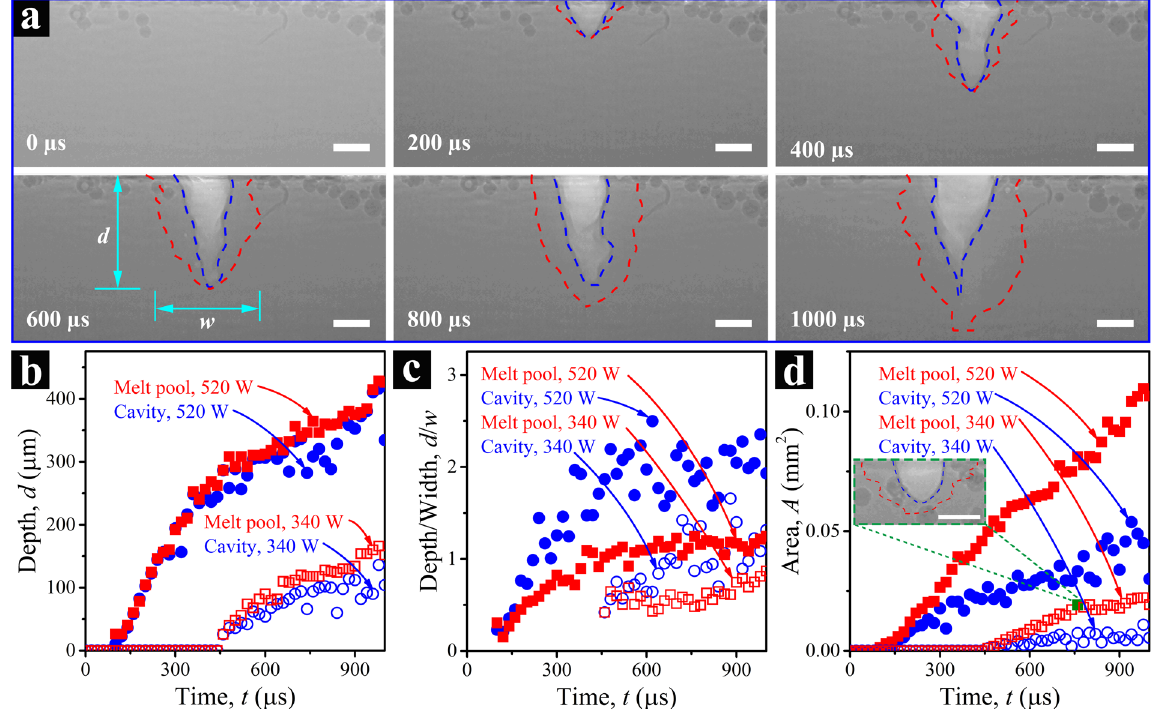
Figure 3. Dynamic evolution of the melt pool in laser powder bed fusion processes of Ti-6Al-4V. ( a ) X-ray images of melt pools in the metal base at t = 0, 200, 400, 600, 800, and 1000 µ s, respectively. The blue dashed line marks the boundary of the cavity or depression zone, and the red dashed line indicates the liquid-solid interface. The power and size of the laser beam are 520 W and ~220 µ m (1/e 2 ), respectively. The laser is turned ON at t = 0, and continues to heat the sample till t = 1000 µ s. The powder particle size is in the range of 5–45 µ m, and the powder layer thickness is ~100 µ m. ( b – d ) Development of the melt pool size and geometry as a function of laser heating time under two different laser power conditions: ( b ) depth, ( c ) aspect ratio (depth/width), ( d ) nominal area. The inset to ( d ) shows a steady-state melt pool configuration at the time indicated by the solid green square. All the scale bars in ( a ) and in the inset to ( d ) are 100 µ